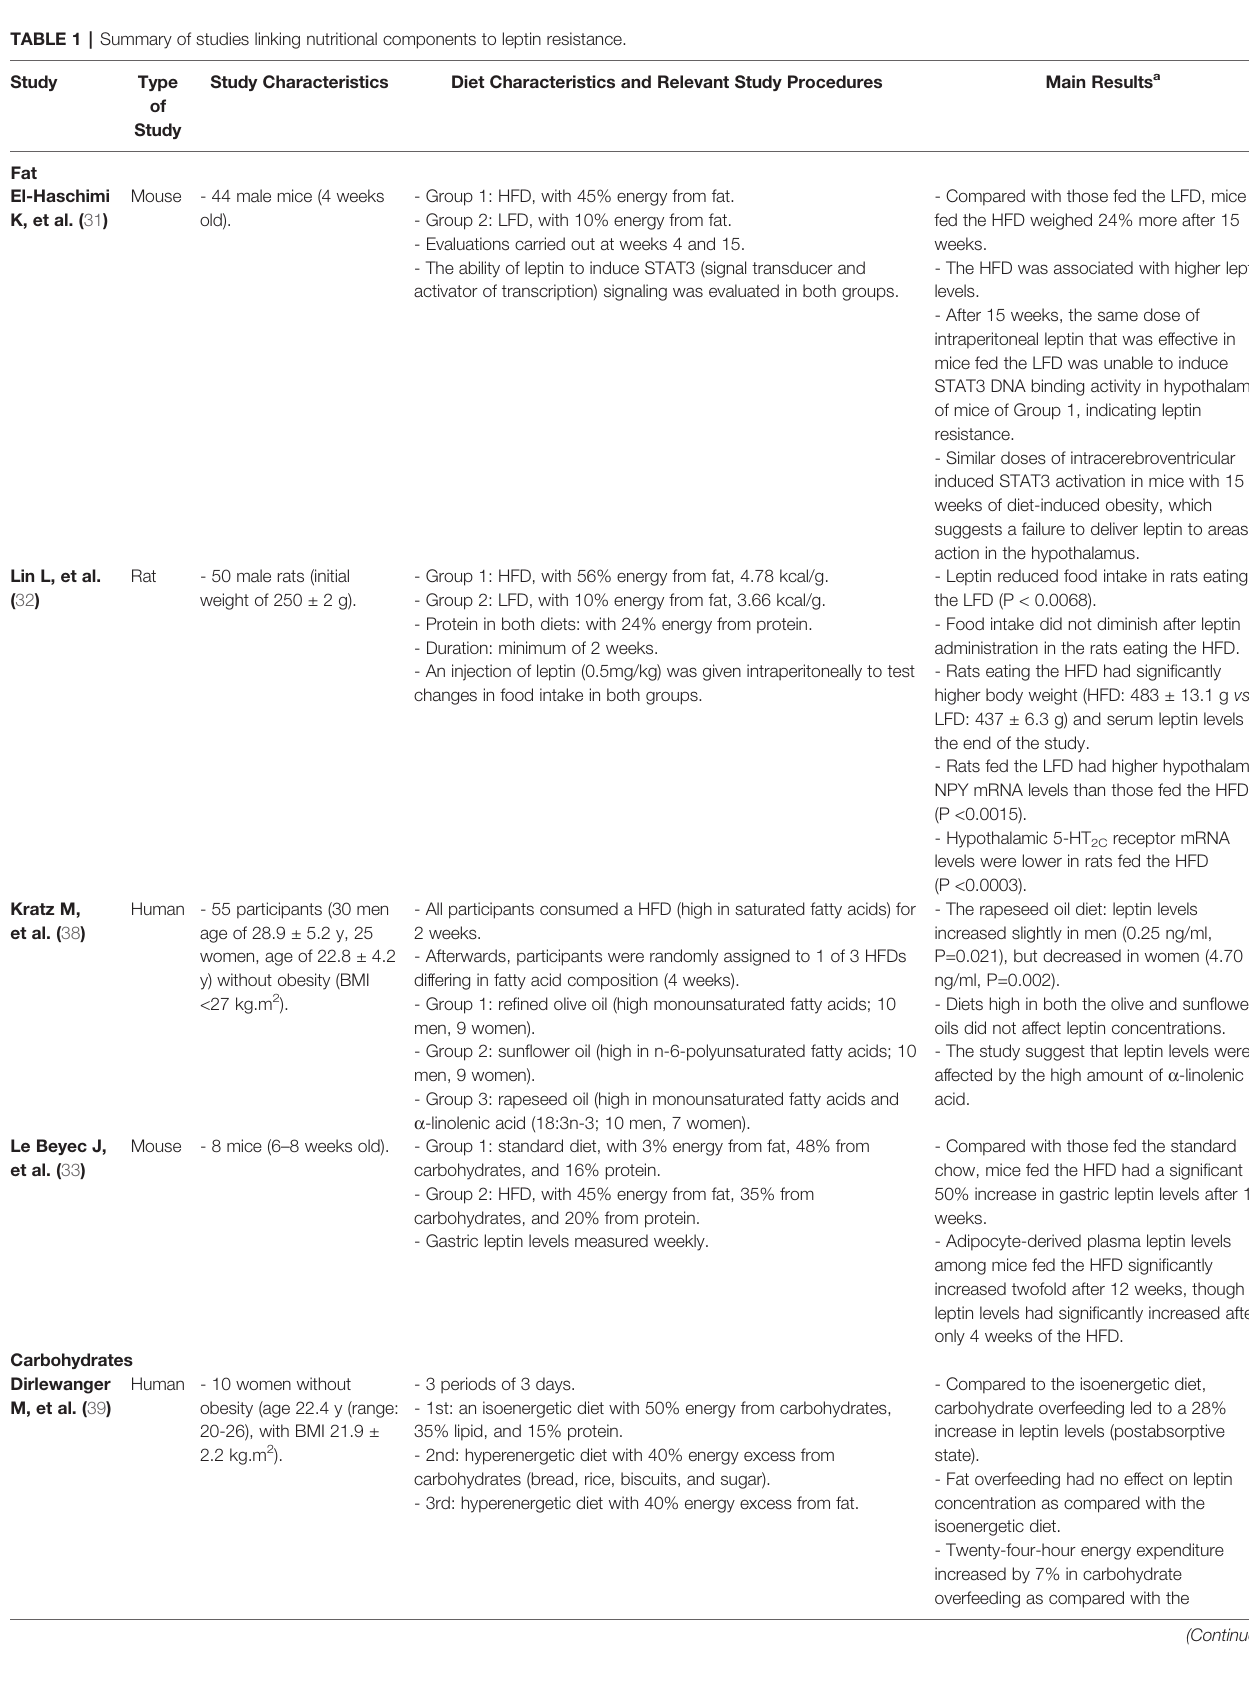
TABLE 1 | Summary of studies linking nutritional components to leptin